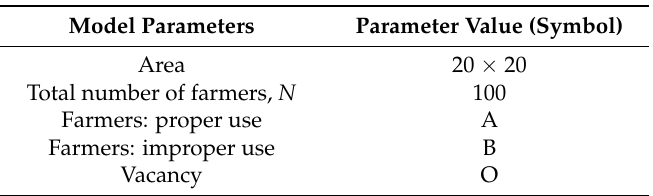
Table 1. Settings of experimental